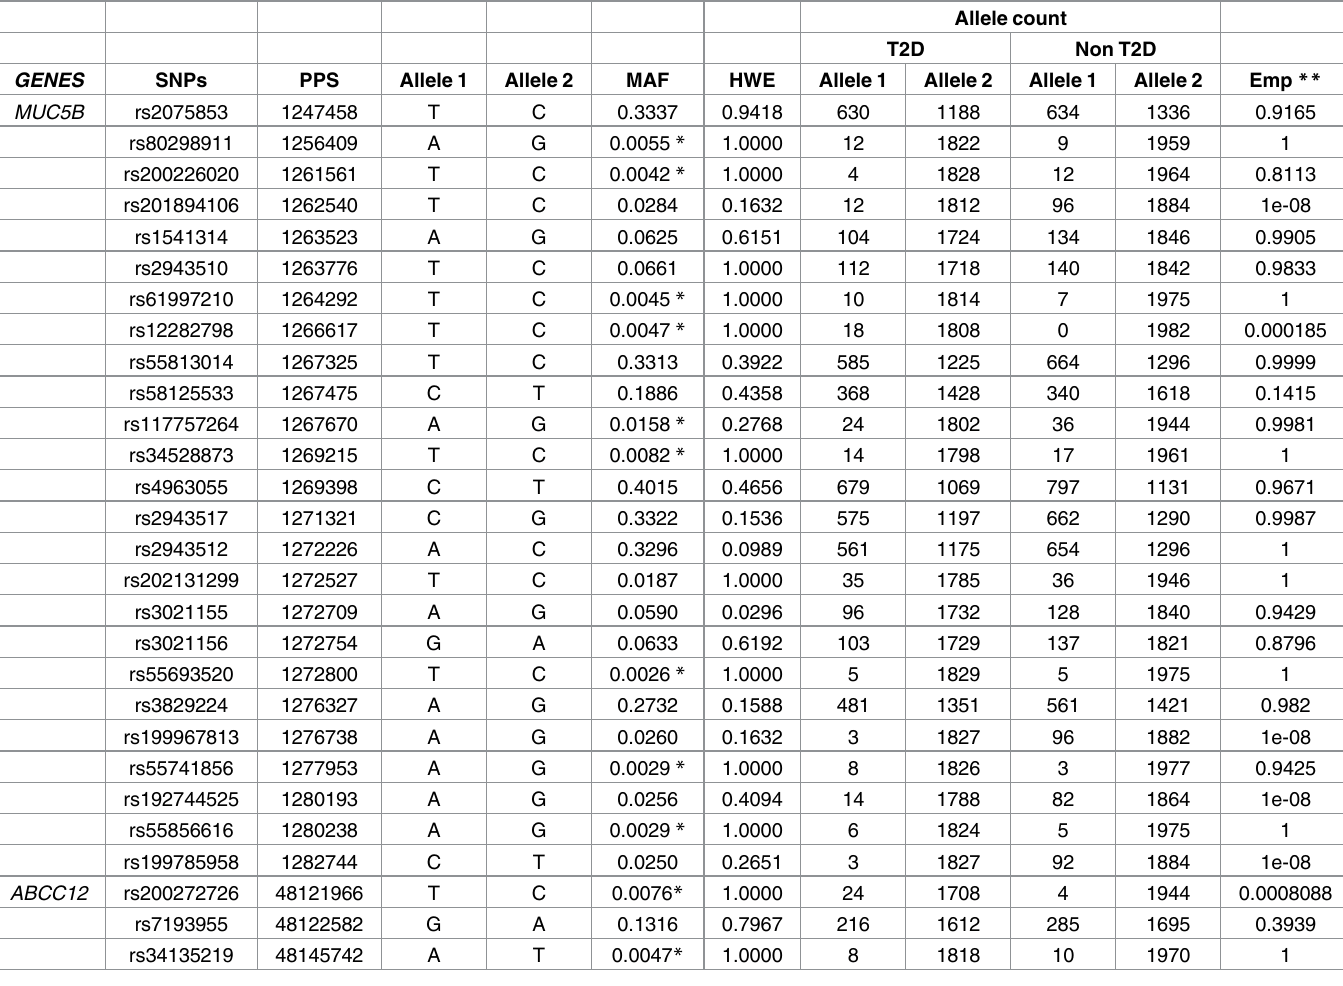
Table 3. Allele Counts by type 2 diabetes status for variants in the MUC5B and ABCC12genes